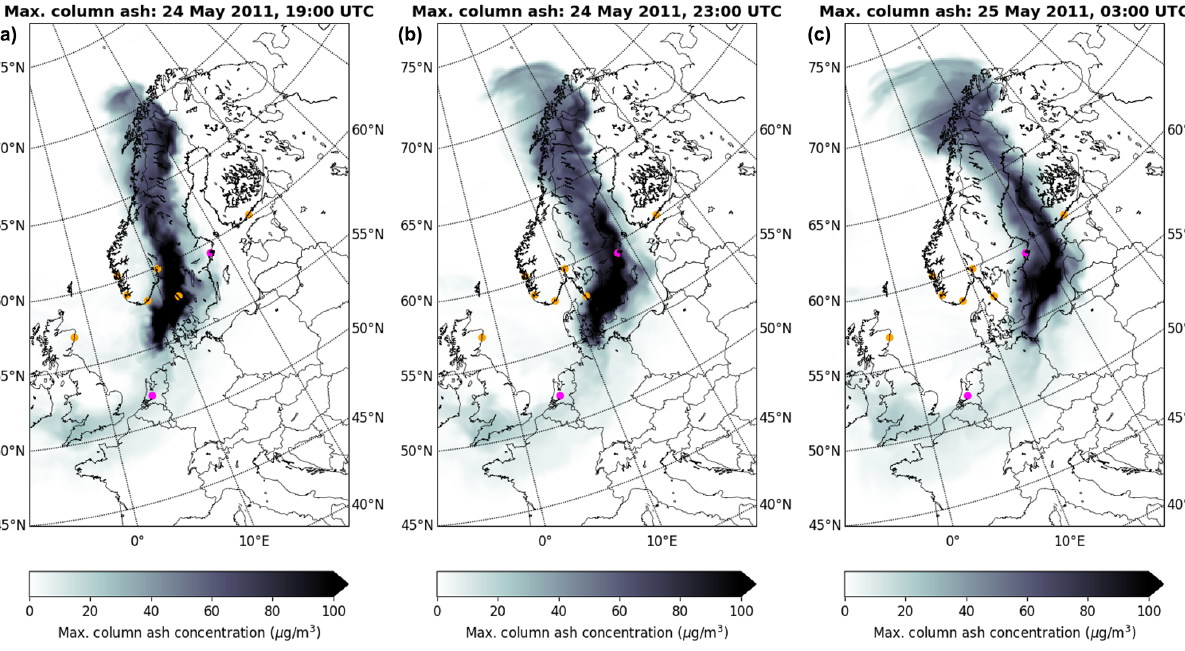
Figure 9. Simulated maximum total ash column for each grid cell on 24 May at 19:00 (a) , 23:00 (b) , and 25 May 03:00UTC (c) . The pink dots indicate the locations of the lidar in Stockholm and Cabauw, and the orange dots indicate the location of the ground